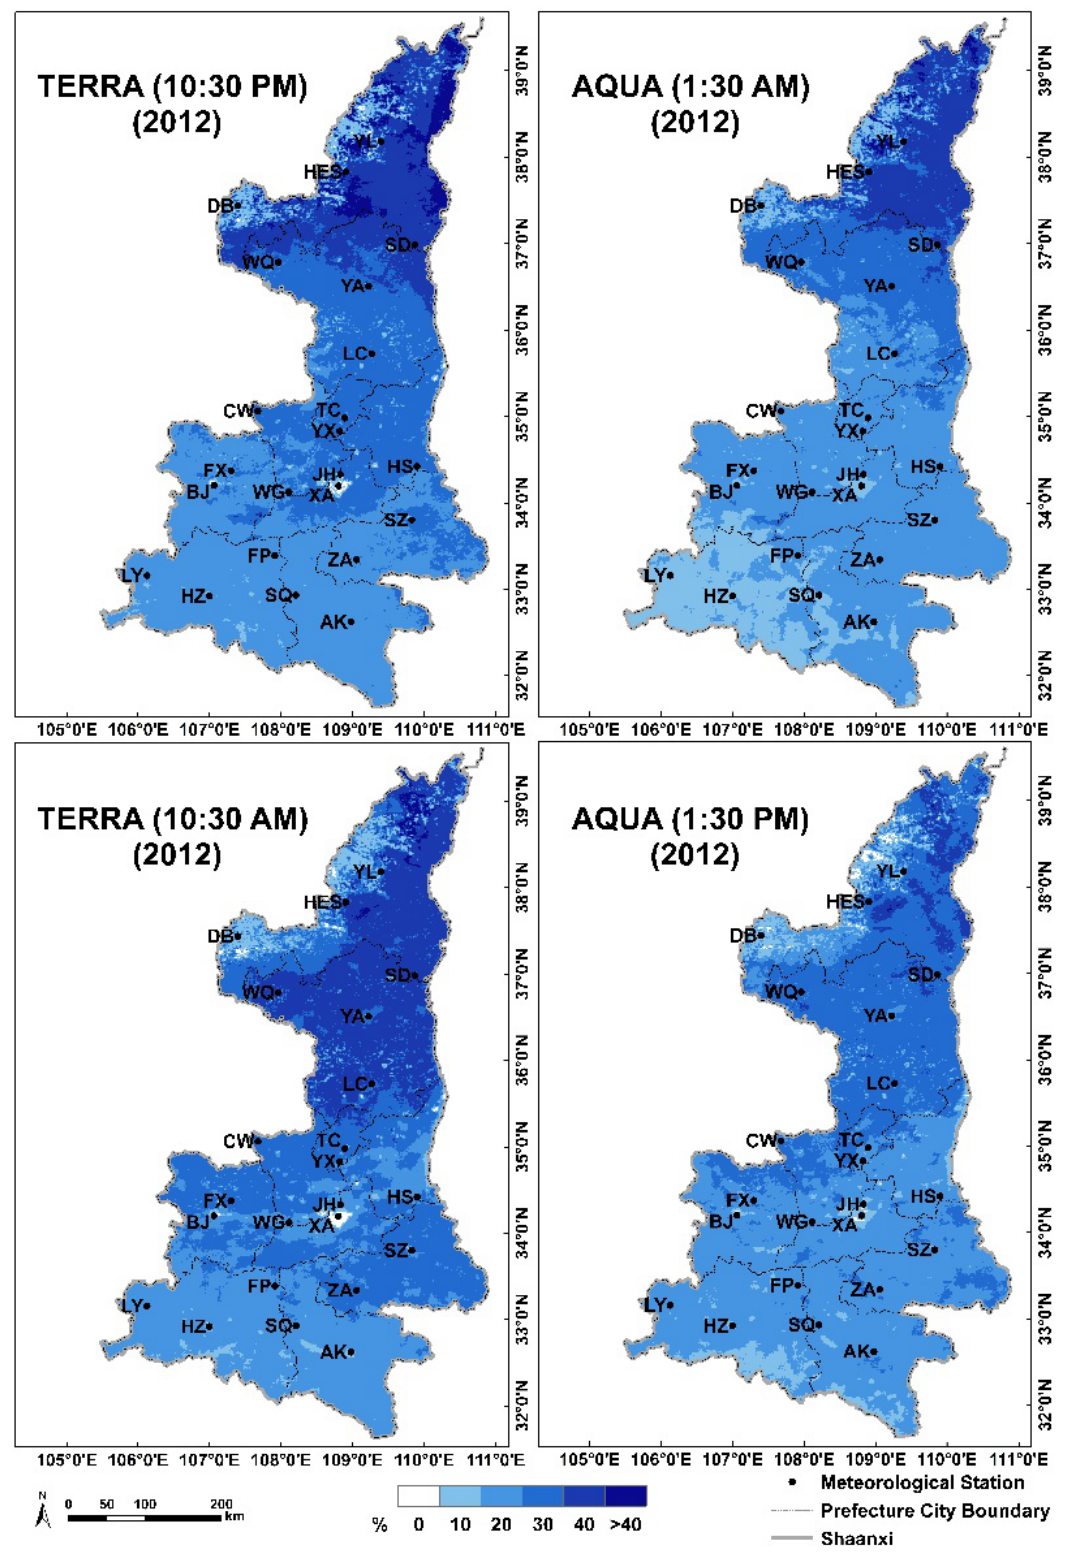
Figure 4. Percentages of available data for daily mean air temperature ( TA ) in 2012 based on daytime and nighttime TERRA and AQUA MODIS land surface temperatures